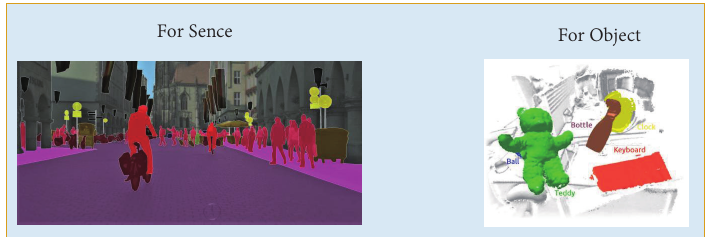
Figure 22. Different types of semantic